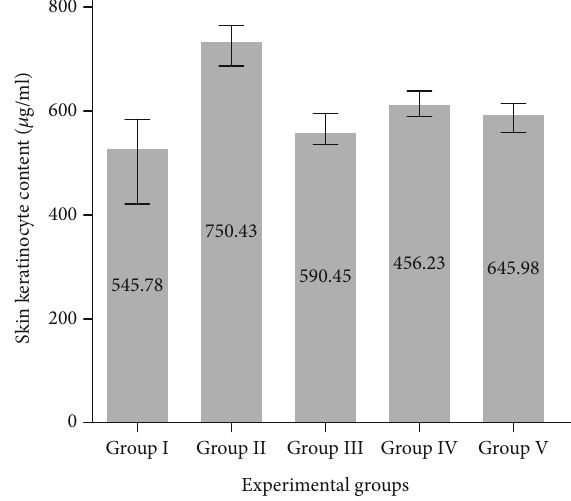
Figure 8: Keratinocyte contents in skin of experimental mice (DMBA-induced mice signi fi cantly ( p < 0 : 05 ) lowers the keratinocytes, but it was increased in FA-treated